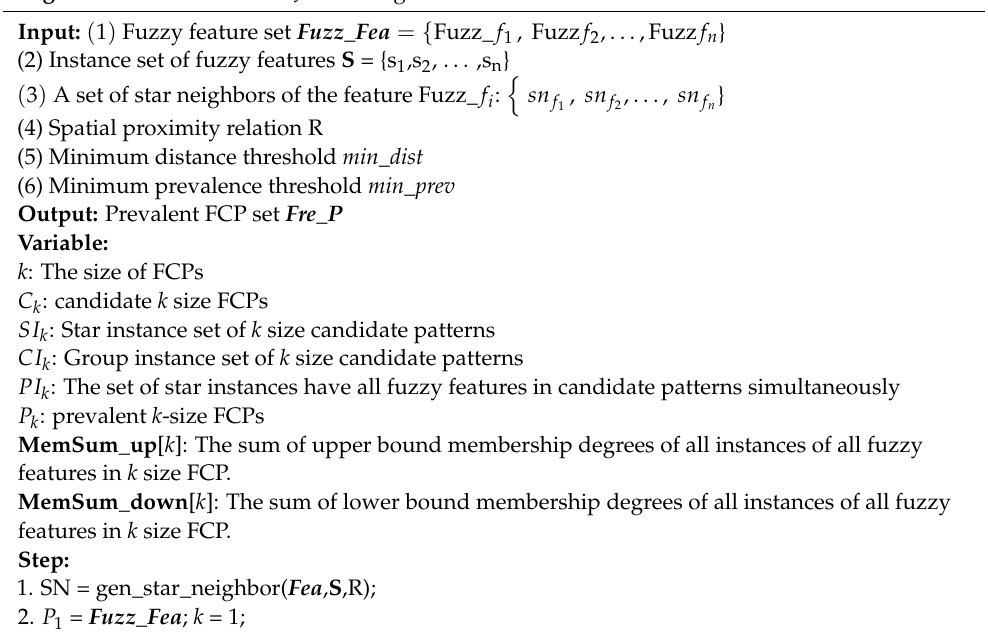
Algorithm 5: The extended Joinless